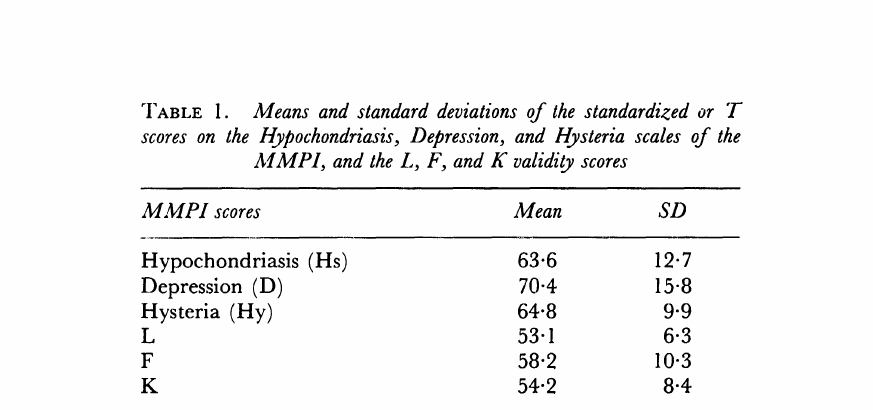
if the standardized or T TABLE I. Means and standard deviations scores on the Hypochondriasis, Depression, and Hysteria scales if the MMPf, and the L, F, and K validity